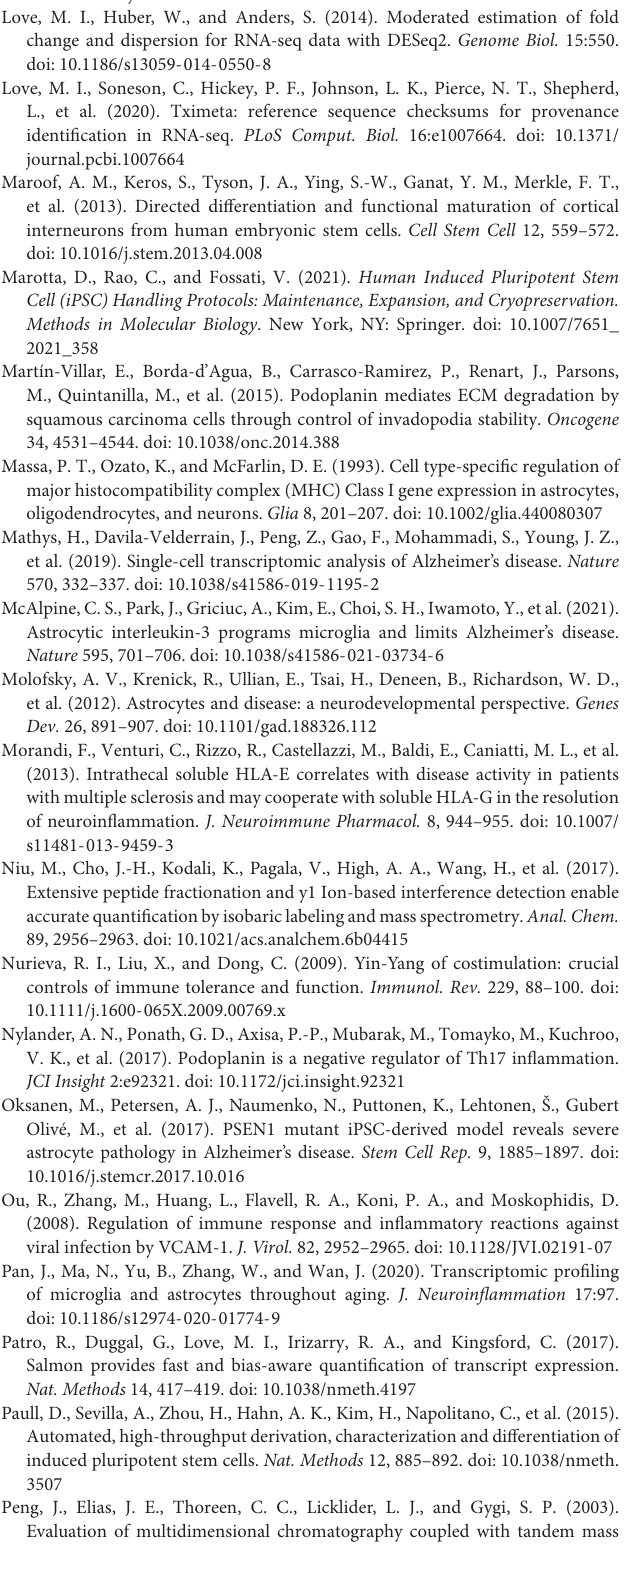
table 1. Cold Spring Harb. Perspect. Biol. 7:a020628. doi: 10.1101/cshperspect.